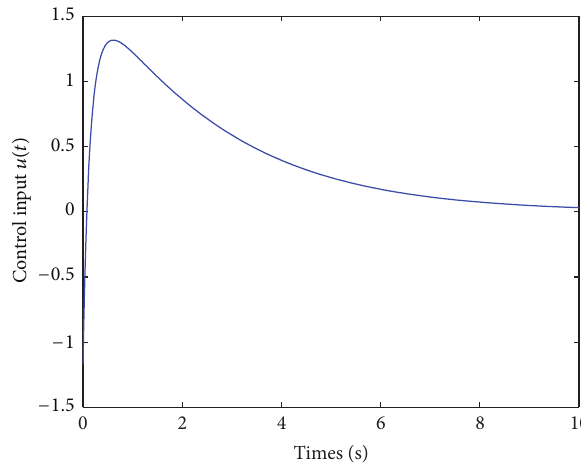
Figure 3: Evolution of the control input without constraints.